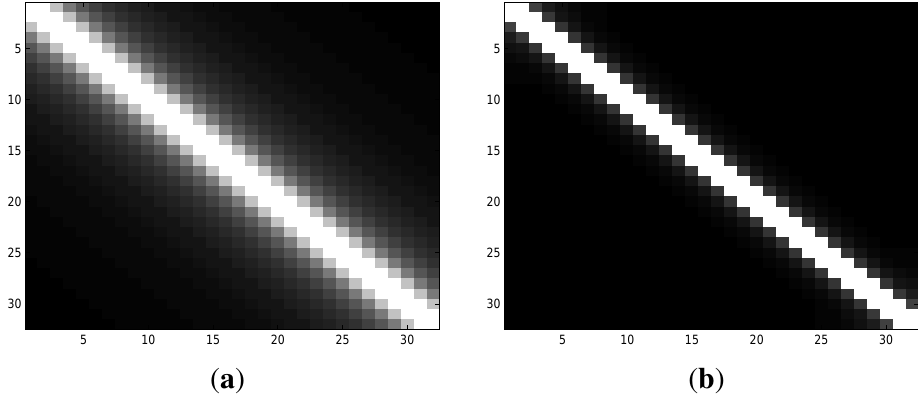
Figure 2. ( a ) Influence matrix for a set of 32 linearly deployed sensor-actuator system with a polynomially decaying influence region; ( b ) inverse of corresponding influence matrix (gray-scale shades are used to represent the magnitude of each matrix element, with black denoting zero and white denoting the maximum